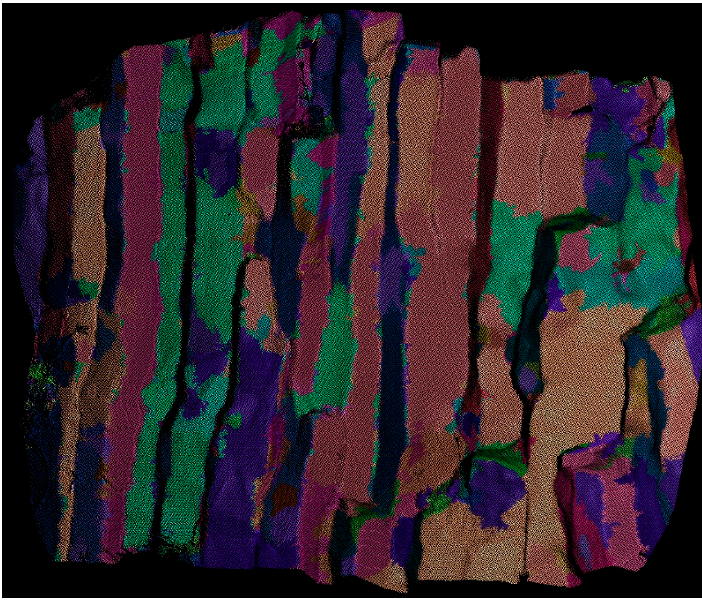
Figure 23. The 3D visualization of the final segmentation results.